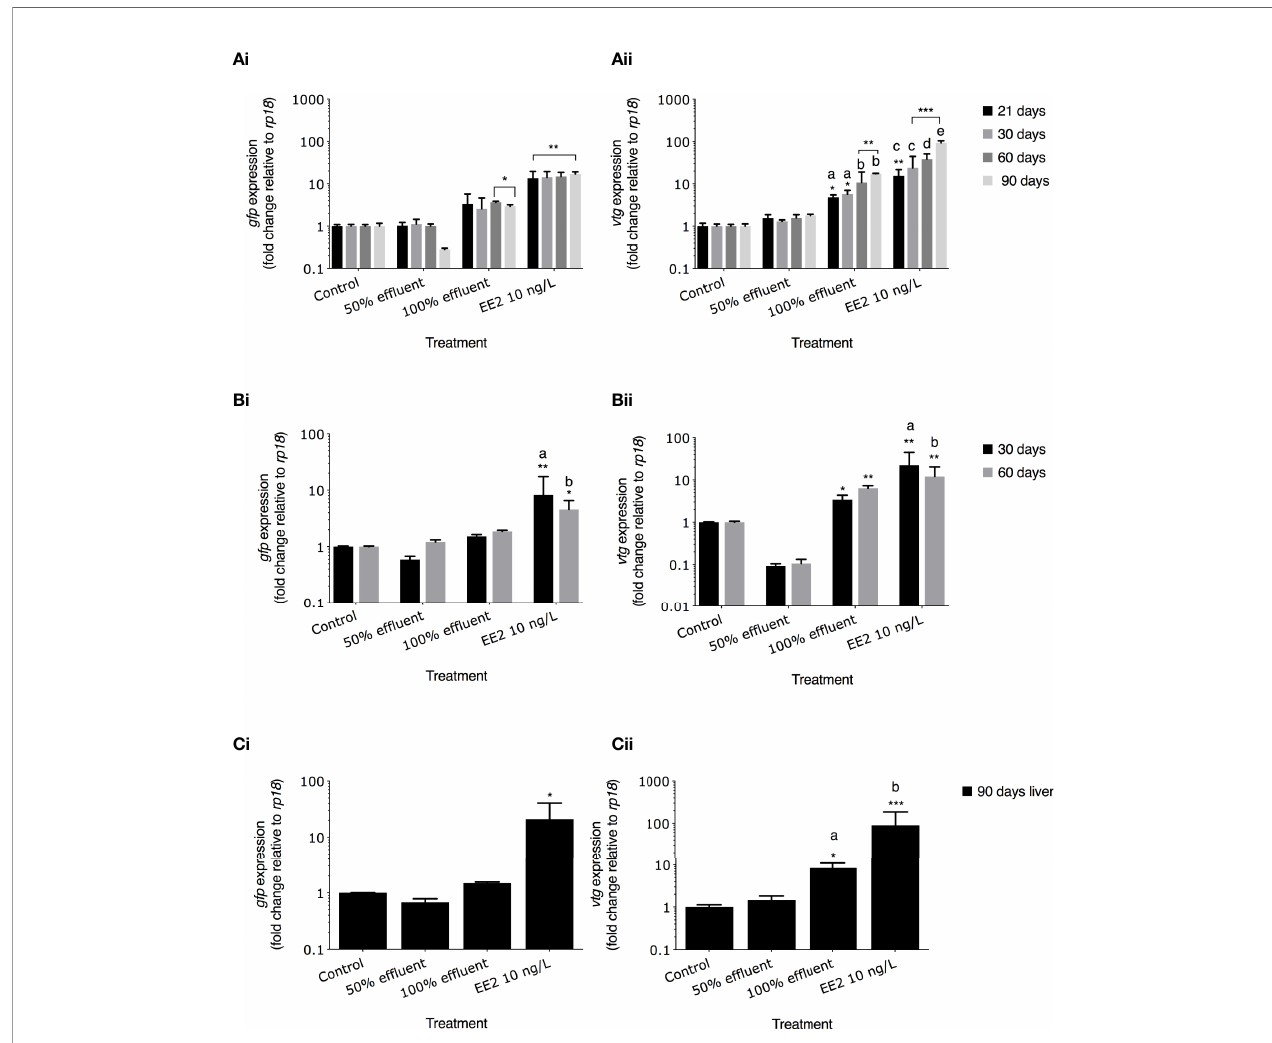
FIGURE 5 | gfp mRNA and vtg mRNA levels in ERE-TG Casper zebra fi sh. Levels of gfp mRNA and vtg mRNA were measured in transgenic zebra fi sh exposed to EE2 (10 ng/L) a WwTW ef fl uent (50% or 100%) or system water control during the developmental periods of (A) 0-90 days, (B) 21-60 days, and (C) 60-90 days. Data are reported as mean ± SE and expressed as fold-change compared with the control. Relative mRNA expression was determined as the ratio or target gene mRNA/ rpl8 mRNA. Asterisks denote a signi fi cant difference (*p ≤ 0.05, **p ≤ 0.01, *** p ≤ 0.001) compared with control. Within groups, different letters denote a signi fi cant difference (p ≤